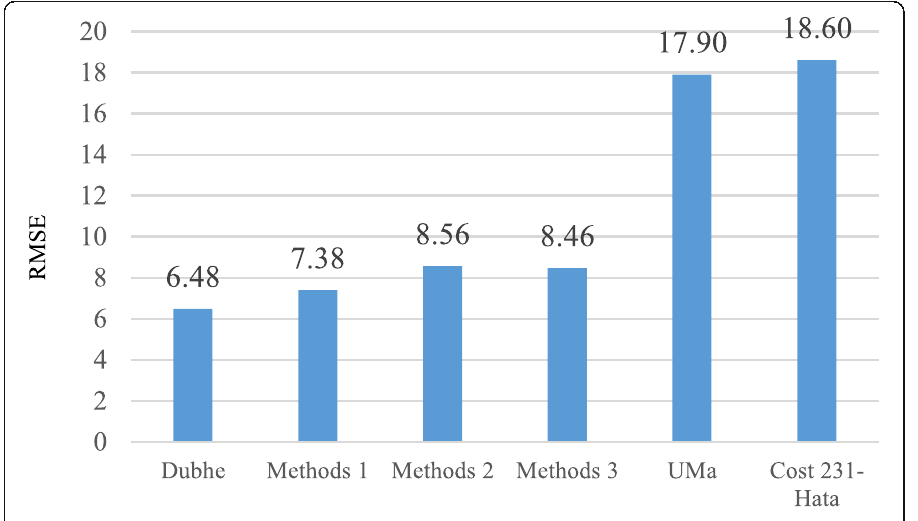
Fig. 7 Comparison of different